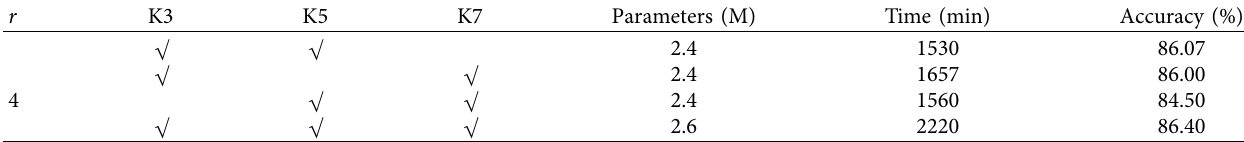
Table 3: Classification results of DKSE module branching taking different null convolution kernels.